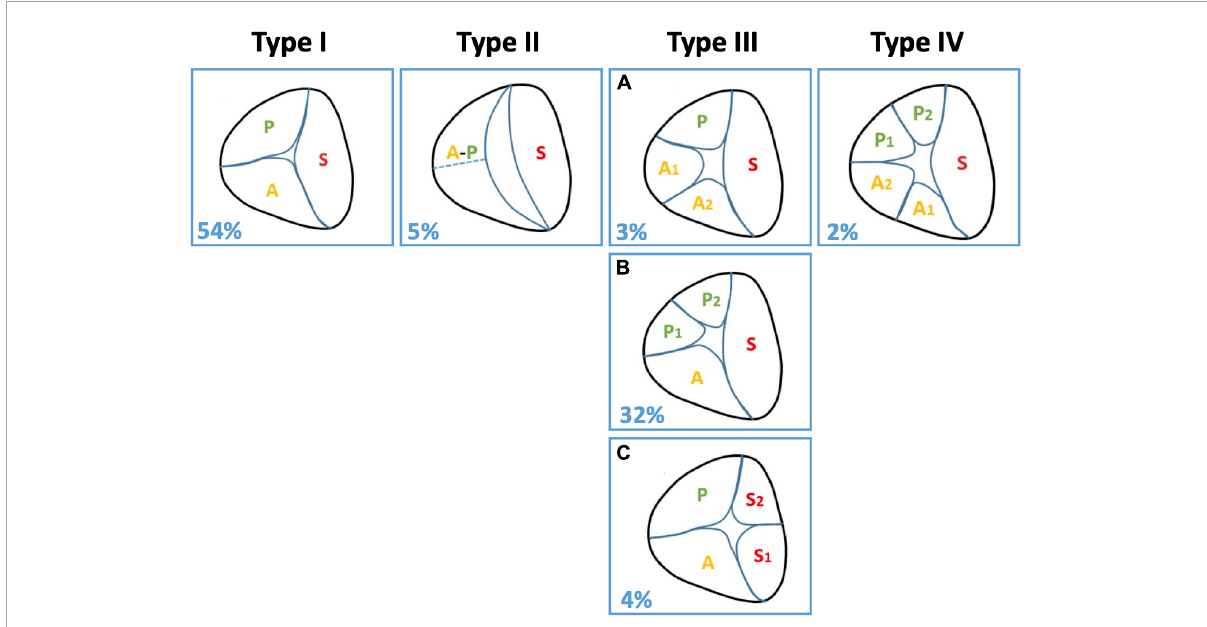
FIGURE3 TV anatomic patterns. This figure illustrates the different types of TV anatomy. A, anterior; P, posterior; S, septal; TV, tricuspid